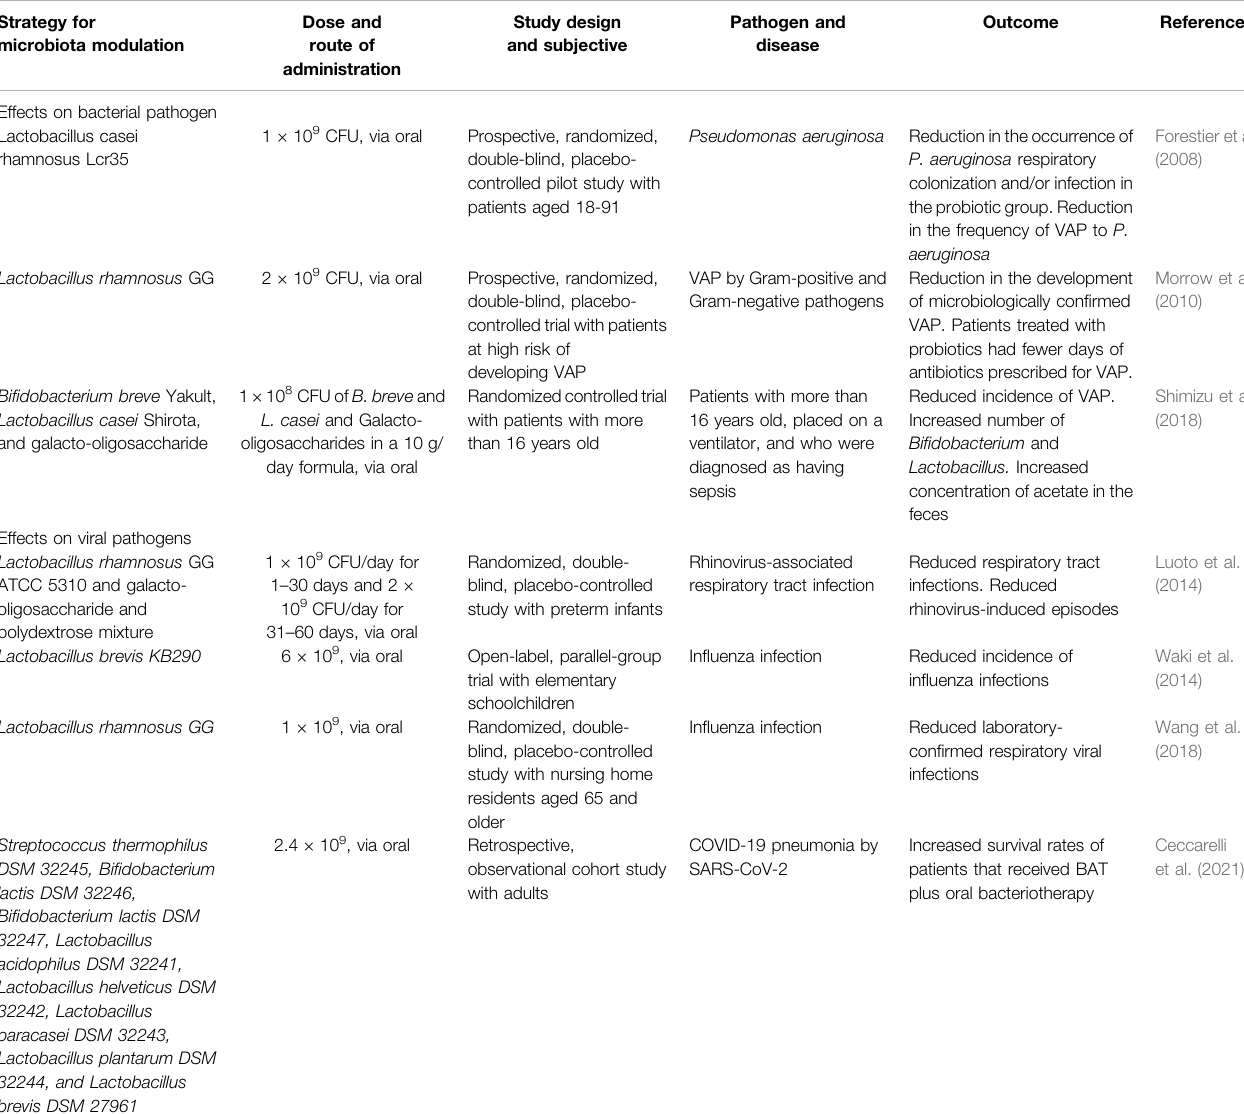
TABLE 2 | Clinical studies on the modulation of the microbiota for treatment of bacterial and viral lung